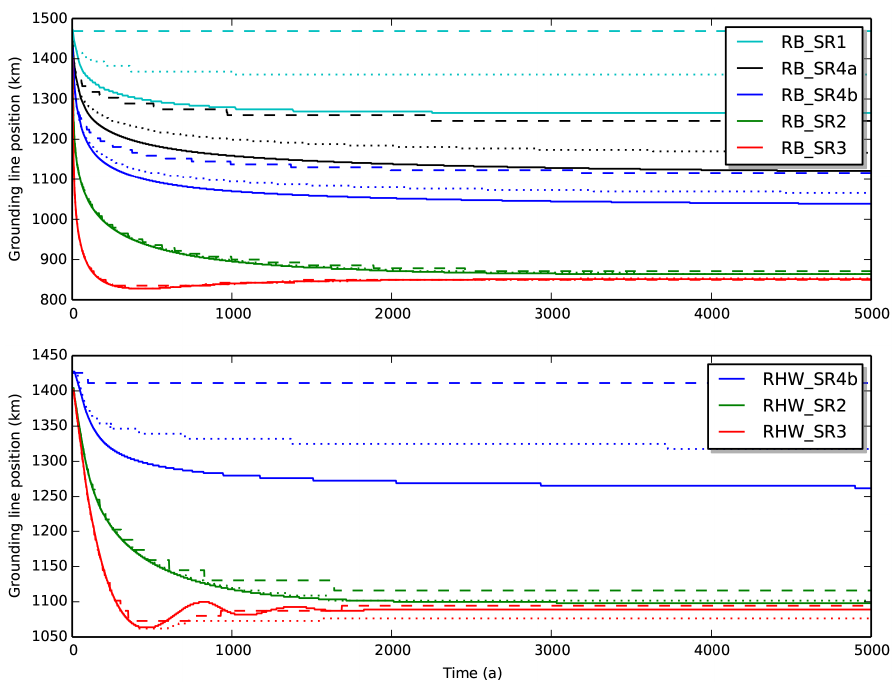
Figure 3. Evolution of grounding line position relative to the inland boundary during retreat simulations with different sliding relations. Sliding relations are described in Sect. 2.1 and Table 1. Experiments are described in Sect. 2.3 and Table 3. Resolutions (Table 2) are coarse (R0, dashed line), medium (R1, dotted line) and fine (R2, solid line). The vertical ordering of the families of curves matches that of the legend tables.